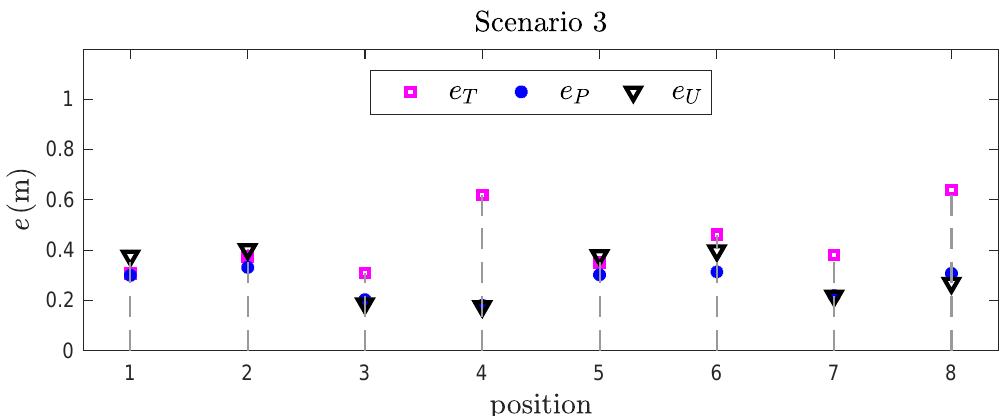
Figure 4. The average errors in Scenario 3 for the TSML algorithm ( e T ), the PSO algorithm ( e P ), and the POST U algorithm ( e U ) are shown in